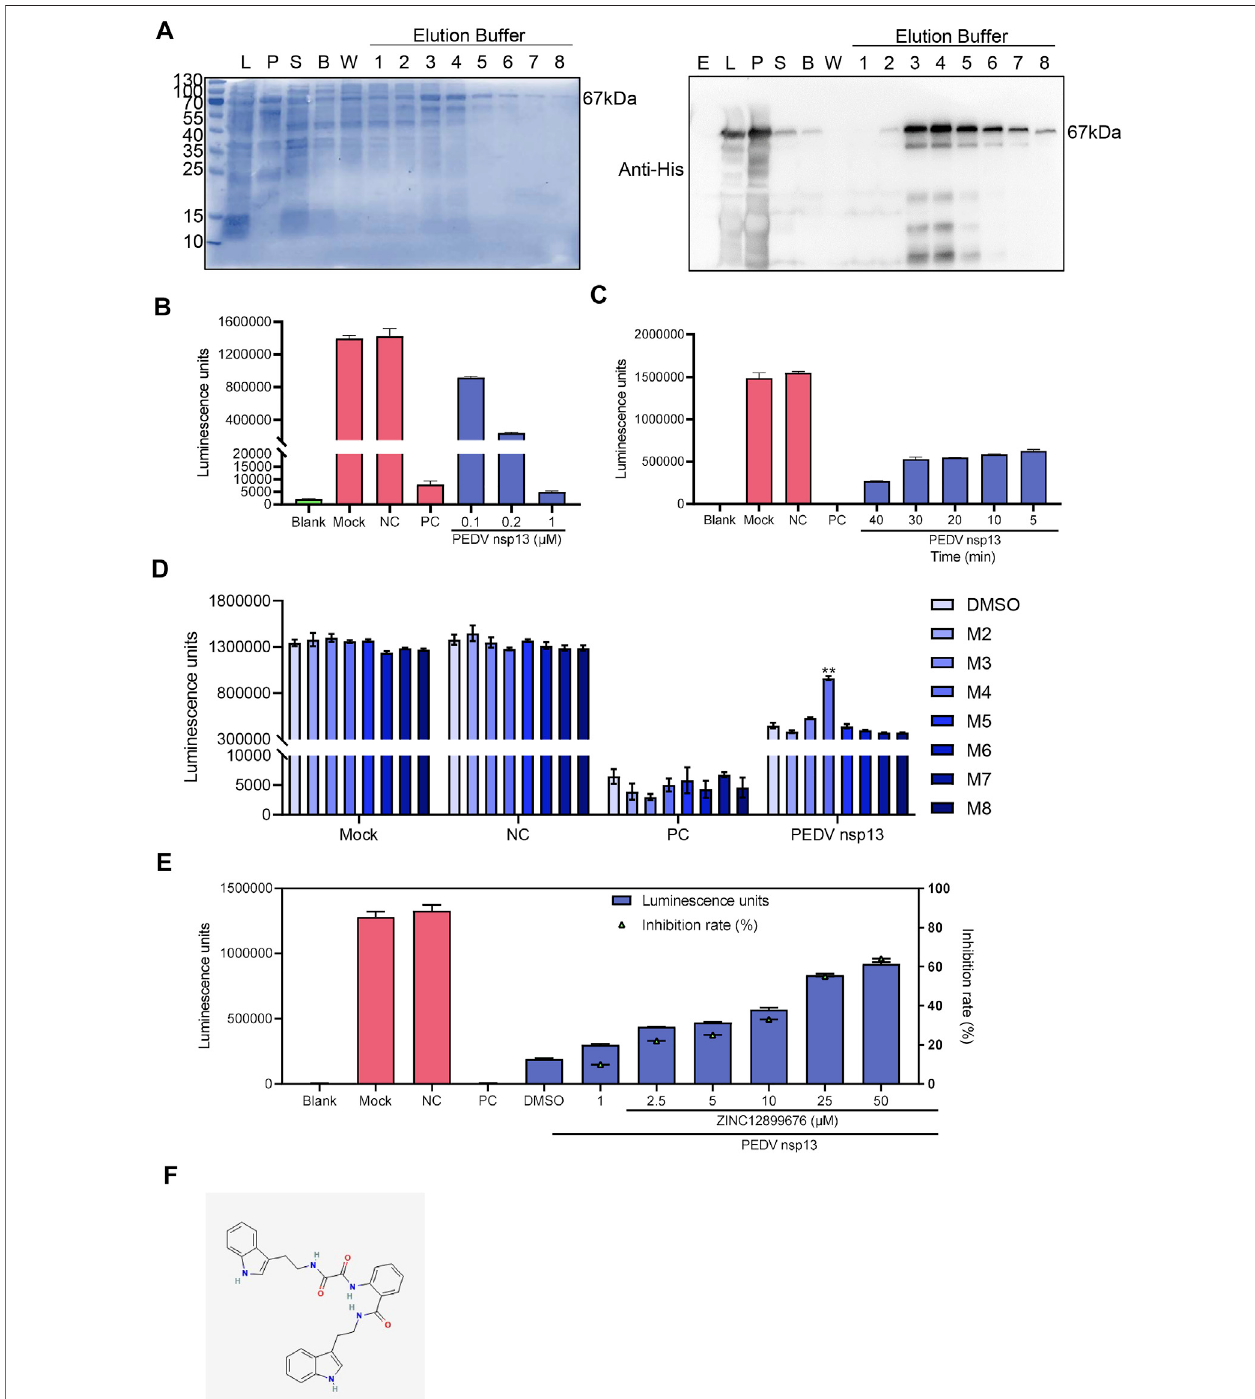
FIGURE 2 | ZINC12899676 inhibits the activity of PEDV NTPase. (A) Puri fi cation of PEDV nsp13. “ E ” represents empty vector, “ L ” represents whole bacteria after induction, “ S ” represents the supernatant after ultrasonication, “ B ” represents the liquid collected after washing using binding buffer, “ W ” represents the liquid collected after washing using washing buffer, and numbers (1 – 8) represent the liquid collected after washing using elution buffer. (B) Puri fi ed nsp13 recombinant proteins (0, 0.1, 0.2, or 0.5 μ M) were incubated with ATP in the reaction buffer at 37 ° C for 20 min, and then, the Kinase-Glo reagent mix was added, and the ATPase activity was measured. (C) PEDVnsp13(0.2 μ M)wasreactedwithATPat37 ° Cfor5,10,20,30,or40 min,andthen,theATPaseactivitywasmeasured. (D) Compounds(25 μ M)or DMSO were added to the reaction mixture 10 min ahead of ATP, and the ATPase activity was measured. (E) Different concentrations of ZINC12899676 were added to the reaction mixture 10 min ahead of ATP, and the ATPase activity was measured. (F) 2D structure of ZINC12899676.